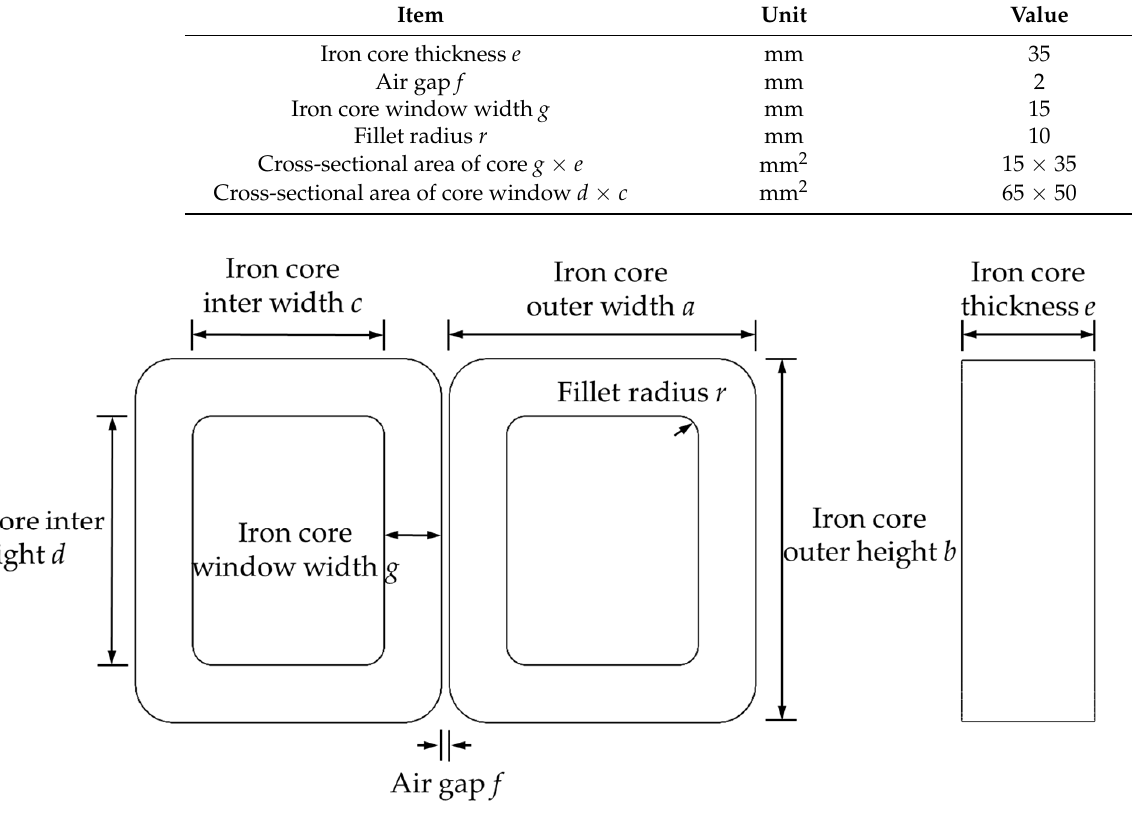
Figure 4. Schematic diagram of shell-type iron core model, where, “a”, “b”, “c”, “d” and “e” are the outer width, outer height, inter width, inter height and thickness of iron core, respectively. “f” and “r” are the air gap and fillet radius, respectively. Table 1. Structure parameters of shell-type nanocrystalline iron core.